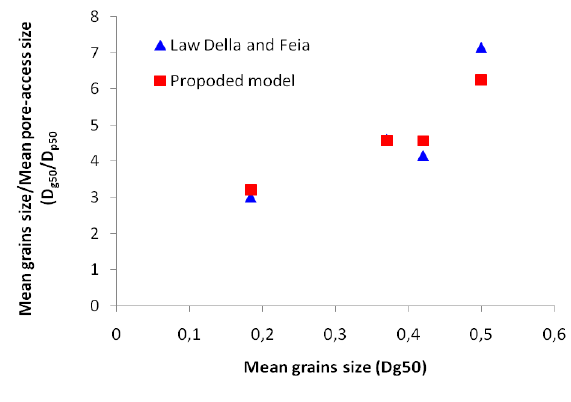
Figure 18: Comparison between the results obtained by the proposed model and those calculated by the law of Della and Feia